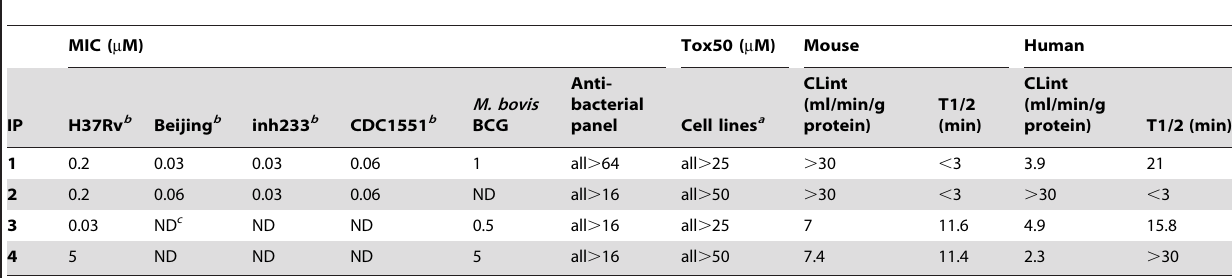
Table 1. Preliminary anti-tubercular activity, cytotoxicity and microsomal stability profile of the HTS hits identified in the IP series.